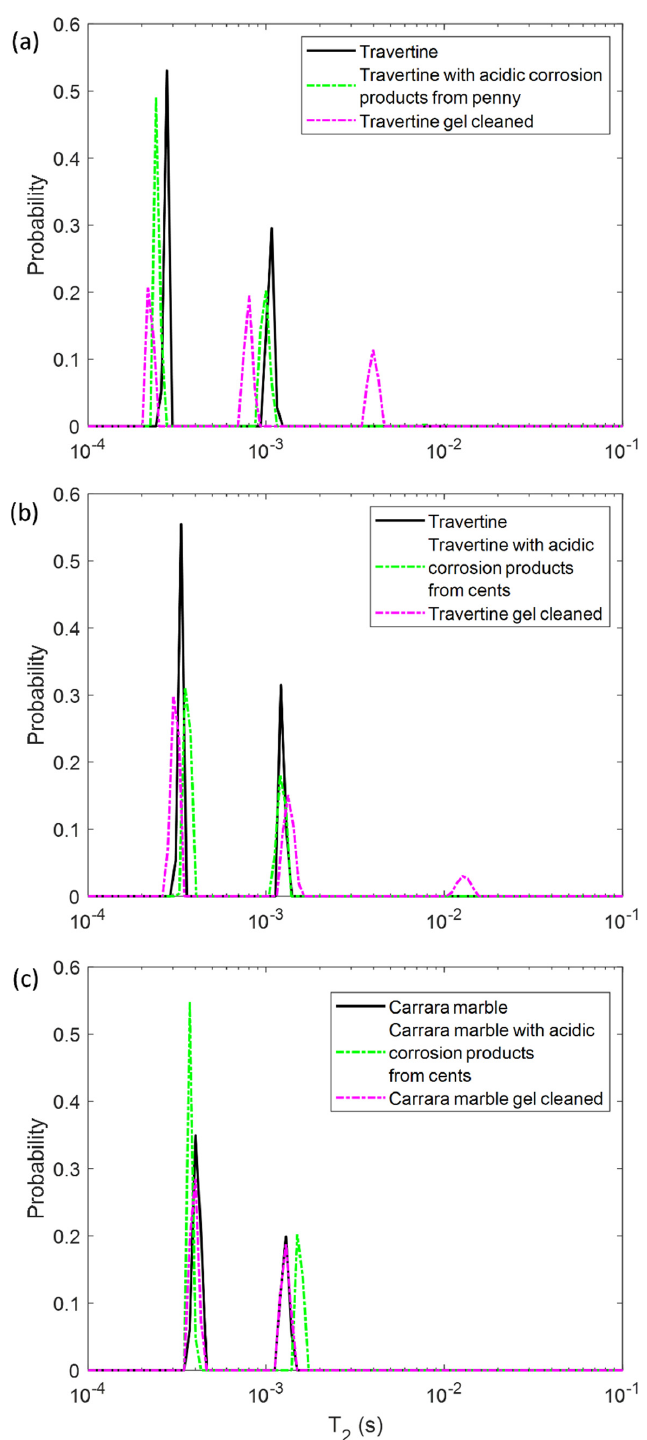
Figure 3. Transversal relaxation time T 2 distribution for ( a ) Travertine 1, ( b ) Travertine 2 and ( c ) Carrara marble before (solid-line) and after the soiling process (green dashed-line), and after the gel cleaning (pink dashed-line).